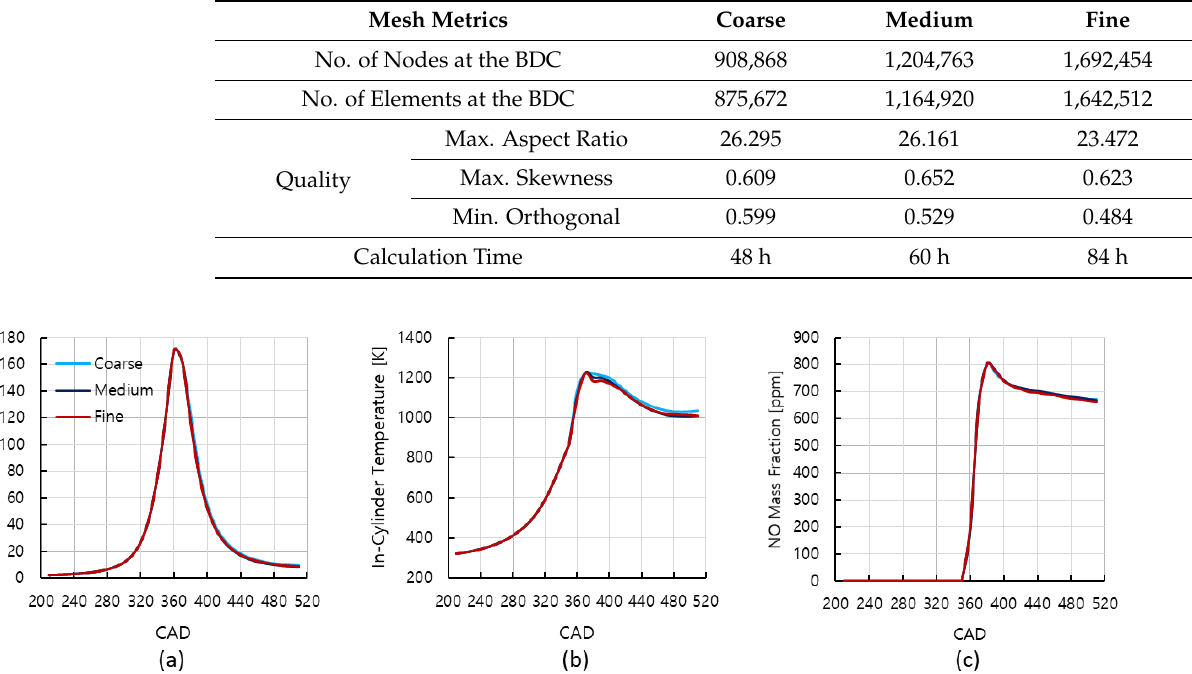
Figure 5. Comparison of the simulation results among various mesh densities: ( a ) In-Cylinder pressure; ( b ) In-Cylinder temperature; ( c ) NO mass